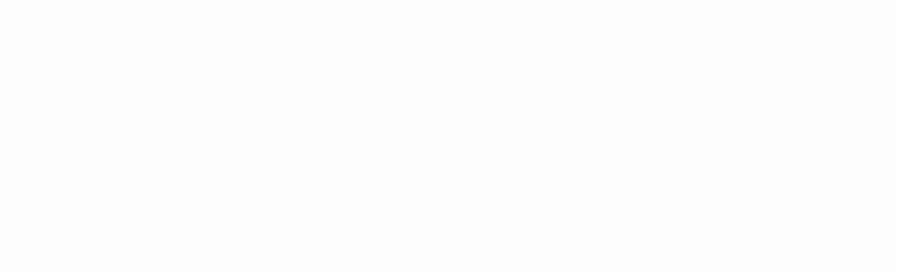
]1 nA Fig. 4: Electrophysiologically defined neuron types n the MNH part of the coculture. Column shows the neuron’s responses to intracellular current pulses after which the neuron is classified: the current steps are indicated below the recording traces. Column 2 illustrates the neuron’s response to a single 100 las voltage pulse in the thalamus part ofthe coculture; the stimulus artifacts are indicated by arrowheads. A: Regular spiking neuron. B: Intrinsically bursting neuron. C: Fast spiking